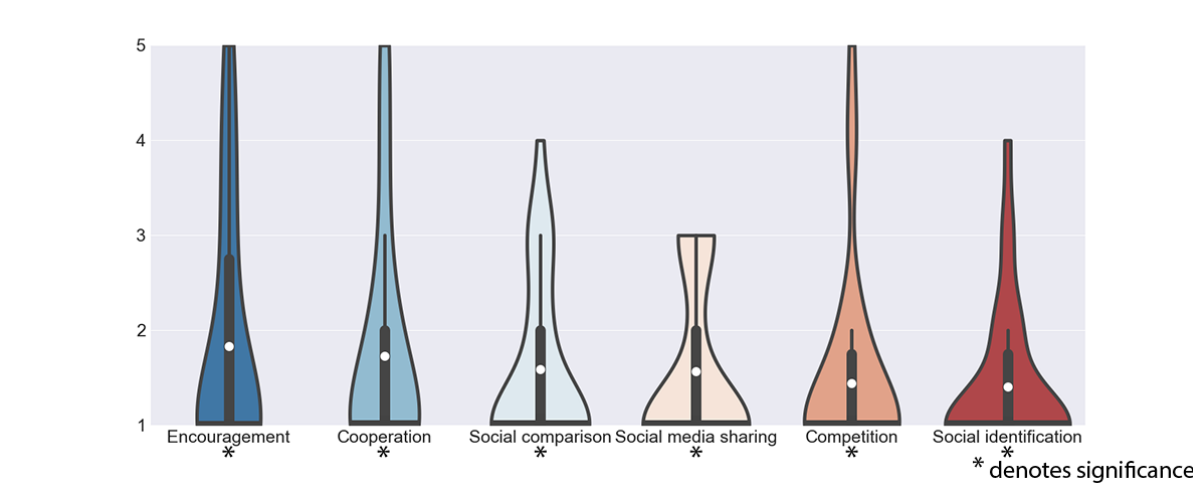
=1.53 σ x=0.85), Social x